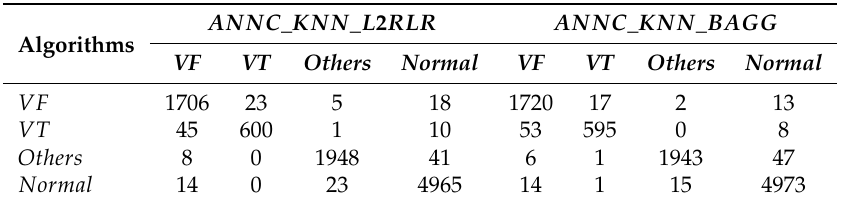
Table 7. Confusion matrix for classification of VF , VT , Others , and Normal classes using the